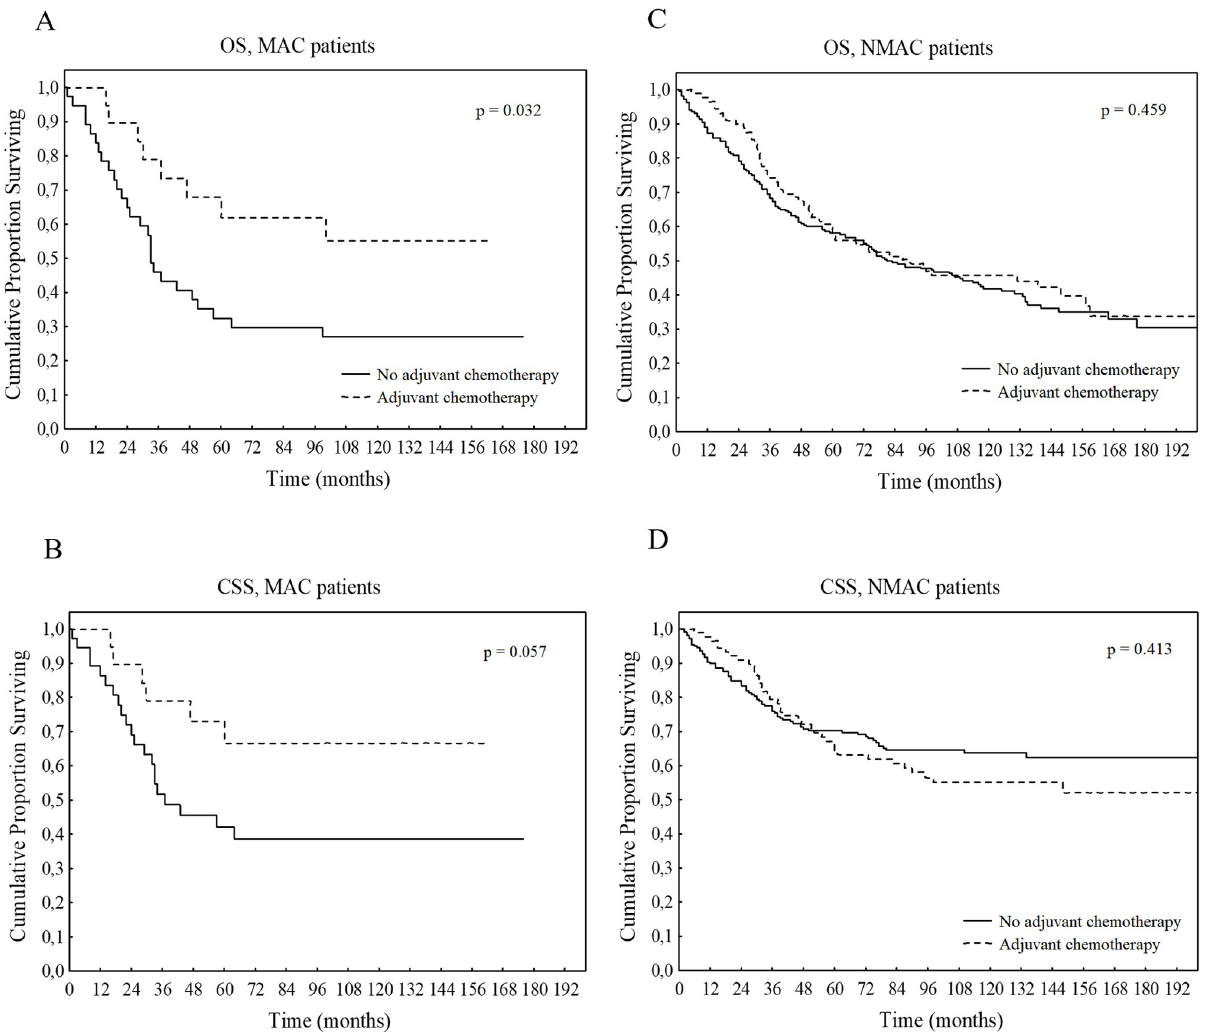
Fig 2. Survival in patients that had adjuvant CT vs . had no adjuvant CT in MAC and NMAC patients. OS, overall survival; CSS, cancer specific survival.